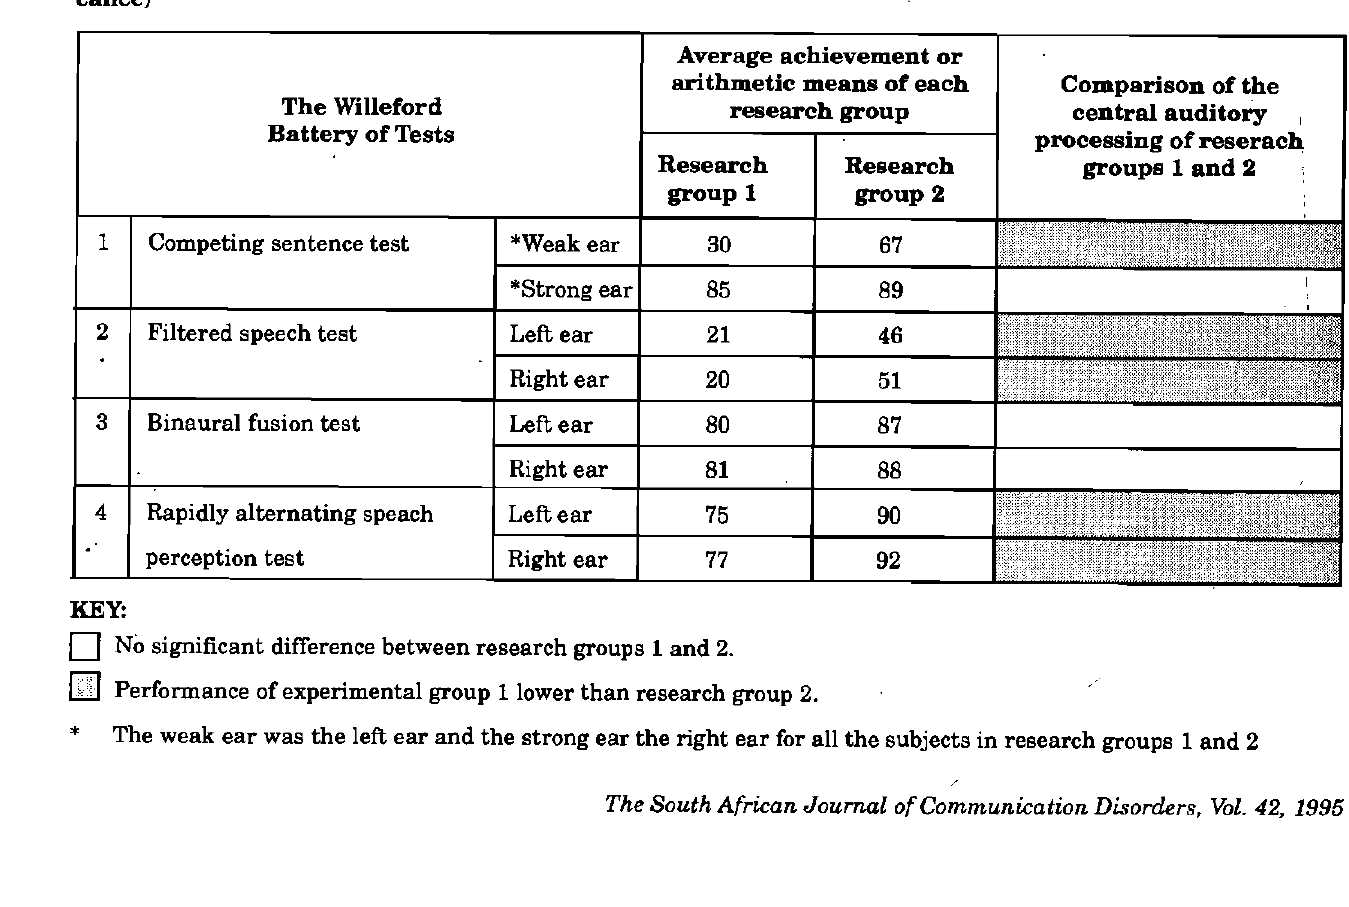
Table 4: A comparison of the central auditory processing of research groups 1 and 2 (at the 5% level of signifi- cance)